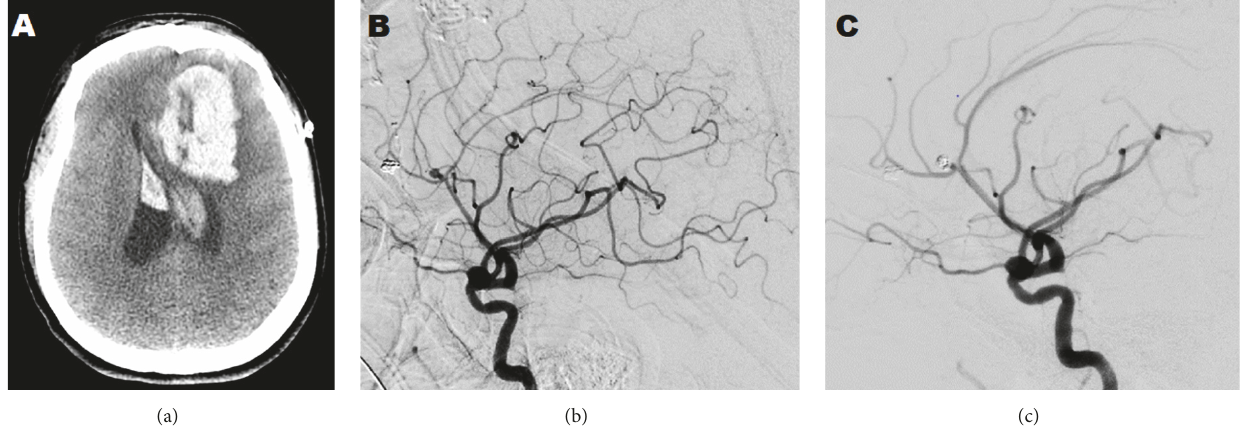
Figure 3: (a) 5 days after discharge in 2016: CT head shows large intracerebral hematoma. (b) A diagnostic cerebral angiogram less than 3 weeks from previousimaging demonstrating intervaldevelopmentof a saccularaneurysm atthe callosomarginal and pericallosal bifurcation. (c) Cerebral angiogram